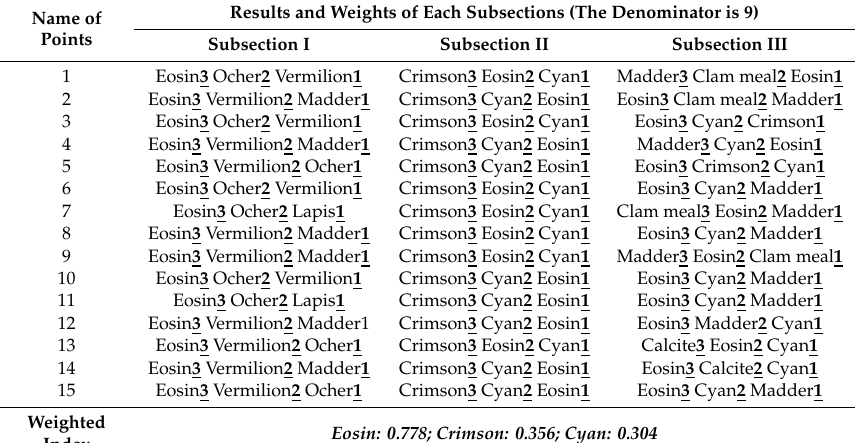
Table 5. The identification results and weights of each subsection in region